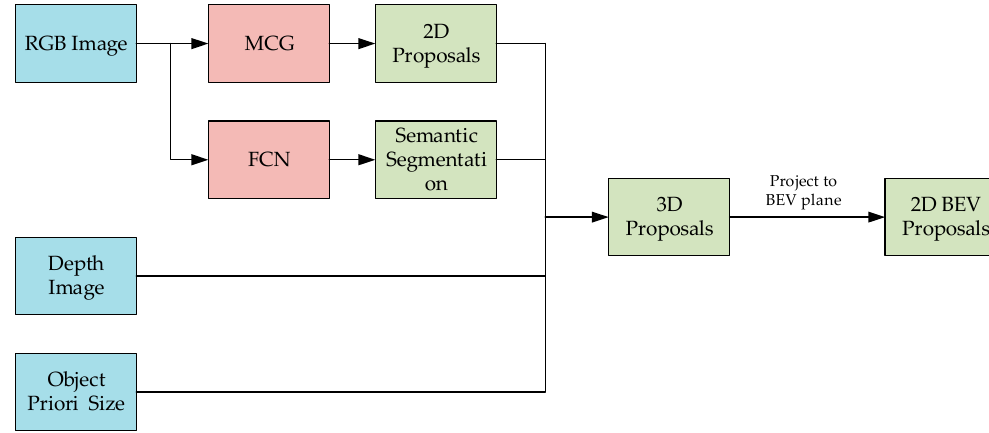
Figure 3. 2D and 3D proposals generation.